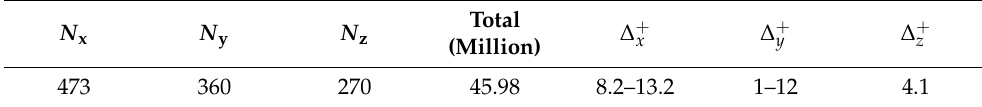
Table 1. Computational grids for the mesh of the channel domain.